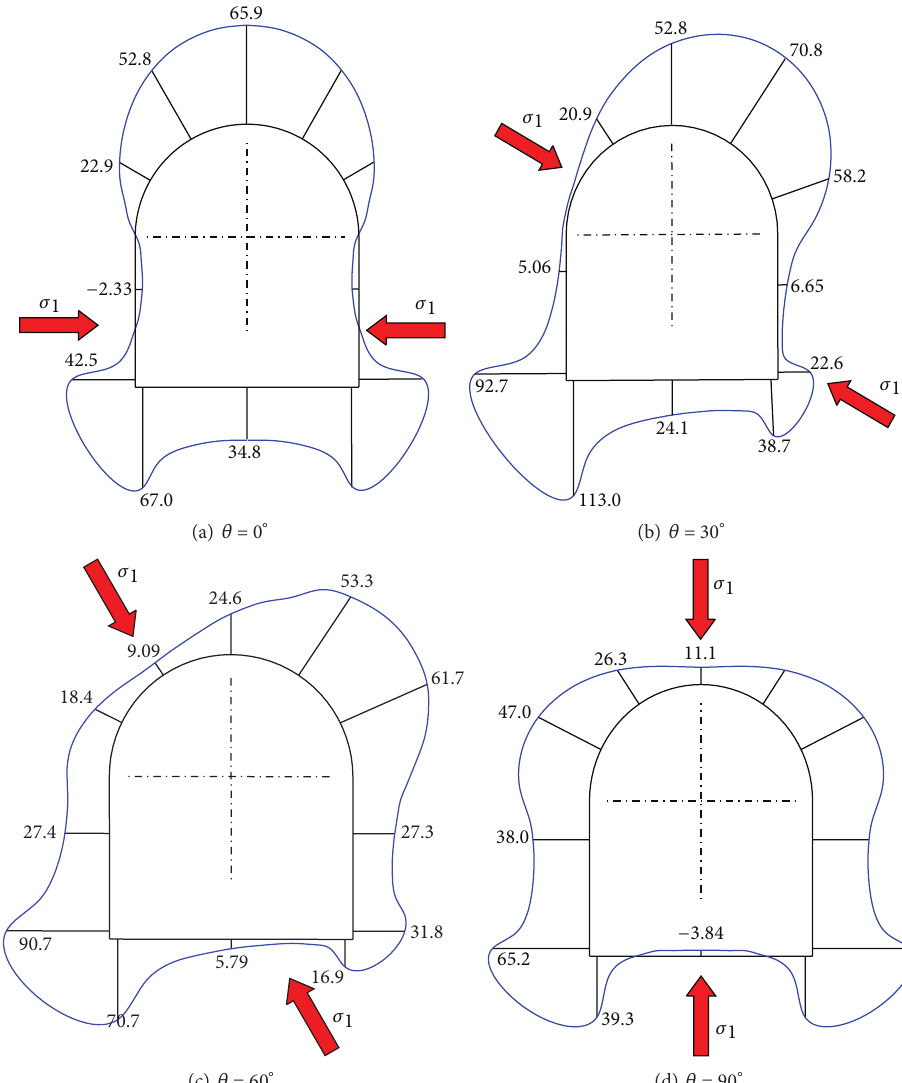
Figure 5: Tangential stress distributions under four different geostress orientations (unit: